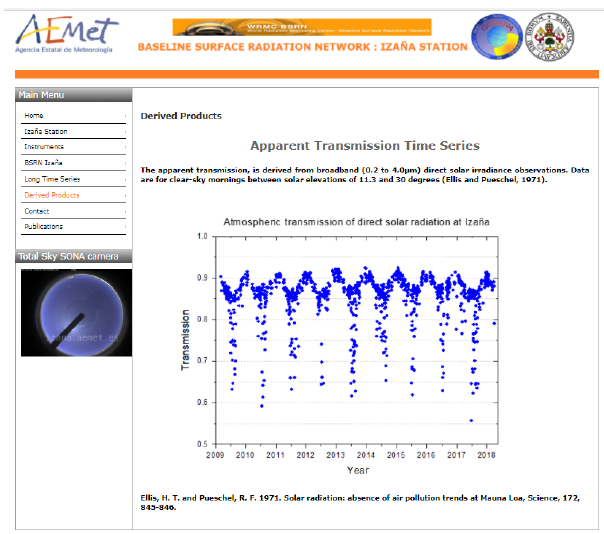
Figure 14. Data time series of direct solar radiation atmospheric transmission determined at IZA for the period